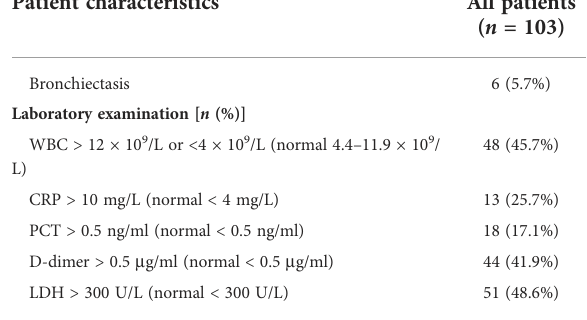
TABLE 1 Clinical characteristics of 103